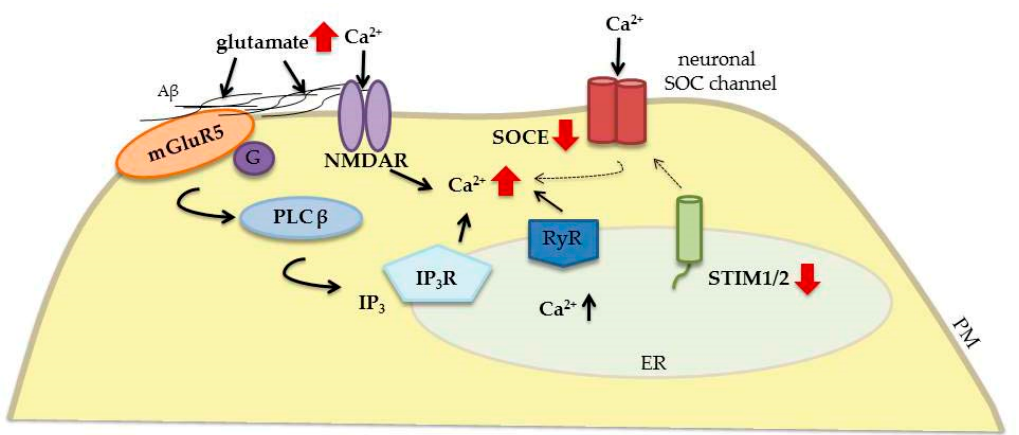
Figure 5. Contribution of neuronal STIM proteins and glutamate receptors to Ca 2 + signaling dysregulation in AD. Elevations of both A β expression and glutamate release lead to the excessive stimulation of glutamate receptors (e.g., NMDARs and mGluR5). The overactivation of